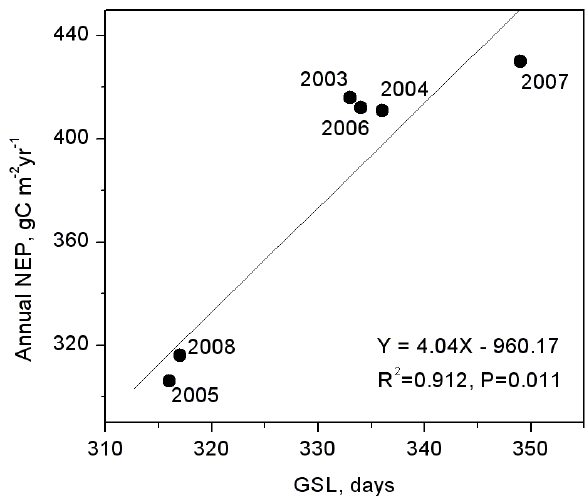
Fig. 9. Relation of annual NEP flux (gCm − 2 ) with the growing season length ( ≥ 5 ◦ C, days). The line was regressed with the data of non-drought years by excluding the year